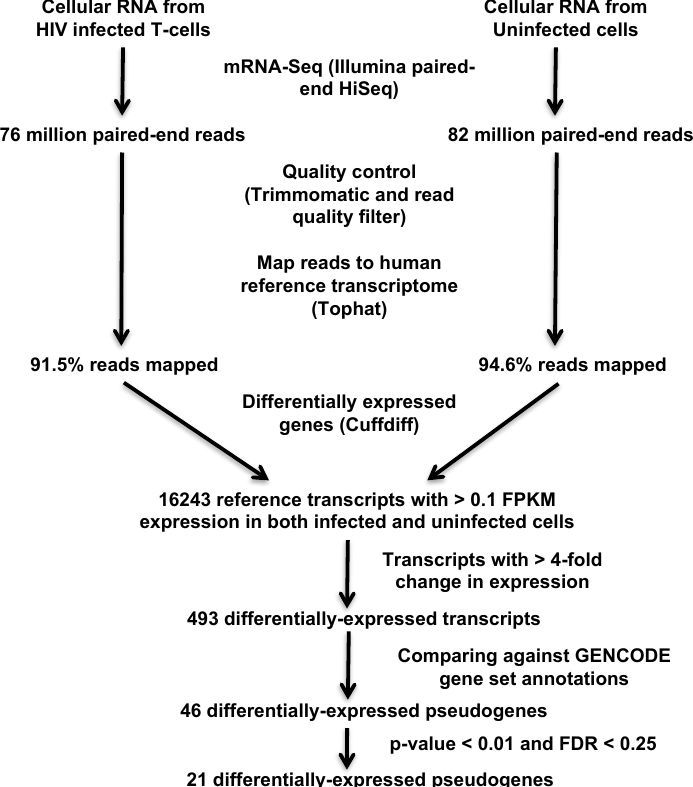
Figure 1. Computational pipeline to identify differentially-expressed pseudogenes from transcriptomic data. The transcriptomic data collected from HIV-1 infected and uninfected H9 T-cells 7 days post-infection were mapped to the human reference transcriptome after quality control analysis. Differentially-expressed pseudogenes were identified following several stringent filtering steps that are the accepted standard in the field: at least >4-fold change in expression, p -value < 0.01 and FDR <